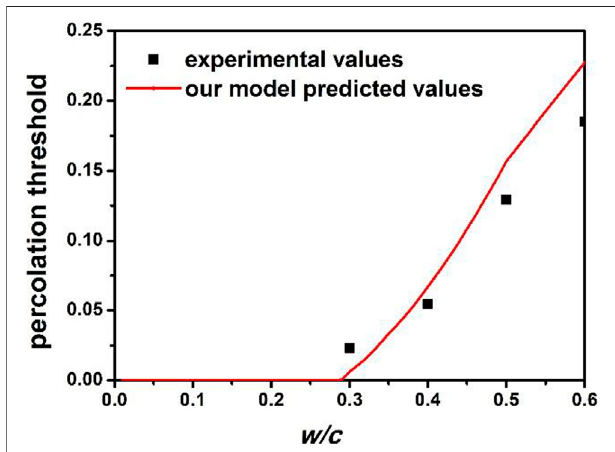
FIGURE 2 | Percolation threshold predicted using our model and experimental results for different w/c